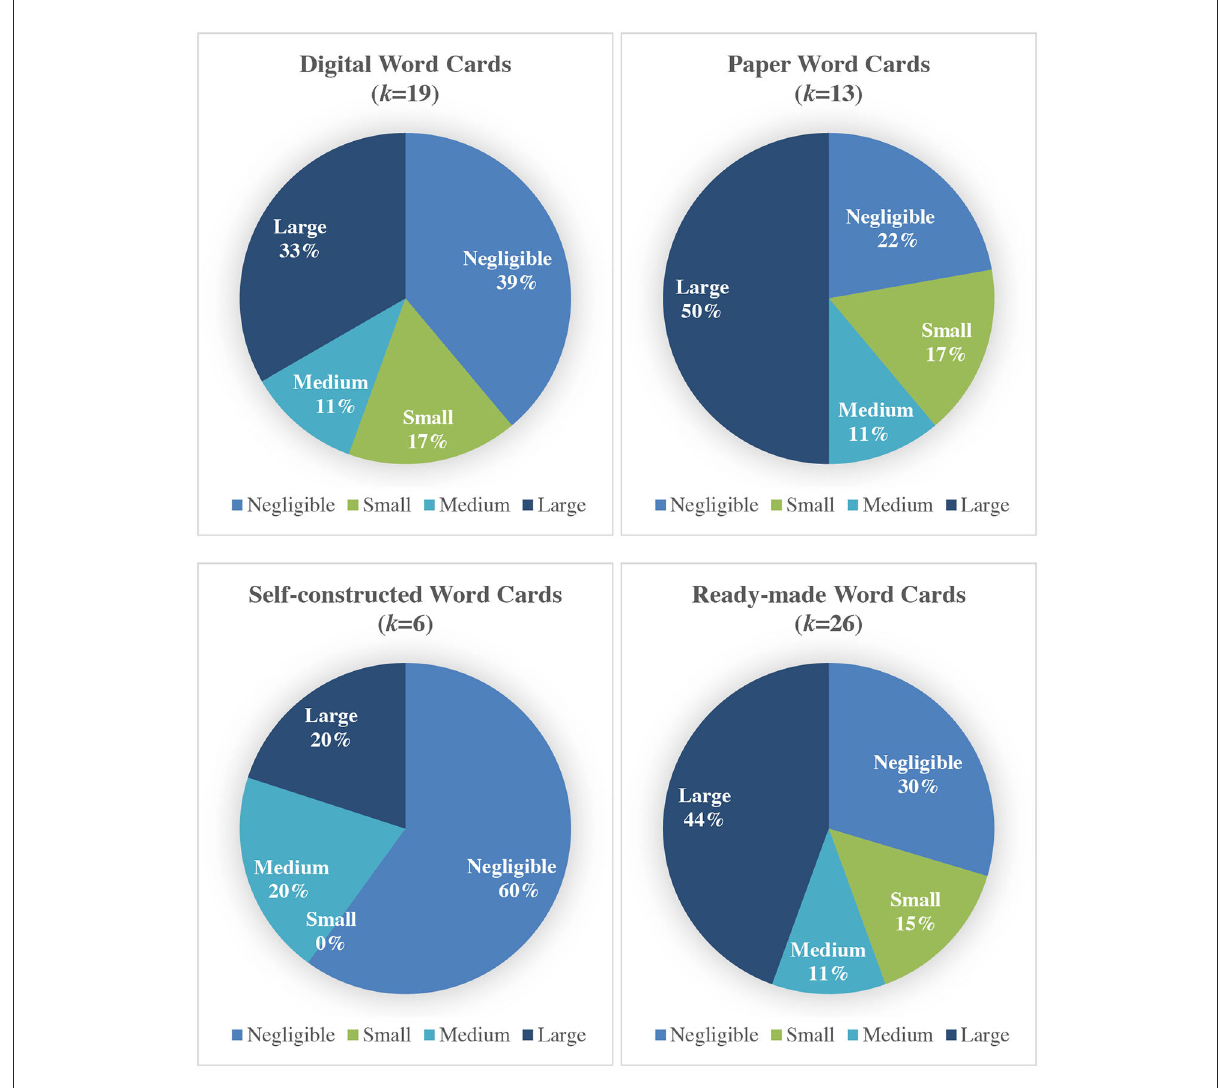
FIGURE4 Effect size plot for type of word cards ( k